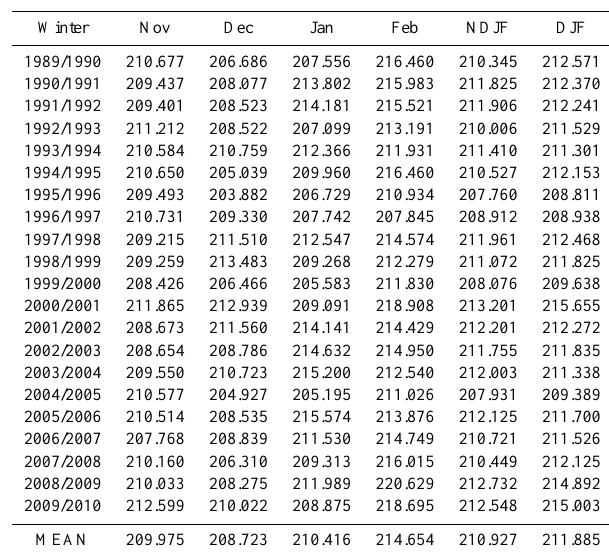
Fig. 6. Anomaly patterns of the absolute temperature (K; color shaded) and the monthly mean temperature (K; solid lines) at the 50hPa surface for December 2009, January, February, and March 2010, respectively. Data: ERA-Interim analyses interpolated on a regular 1 × 1 ◦ latitude/longitude grid. Table 1. Monthly mean polar cap (50 to 90 ◦ N) temperatures (K) at 30hPa calculated from the ERA-Interim data. Last two columns: winter means from November to February and December to Febru- ary, respectively. Red (blue) colours denote unusually warm (cold) Arctic